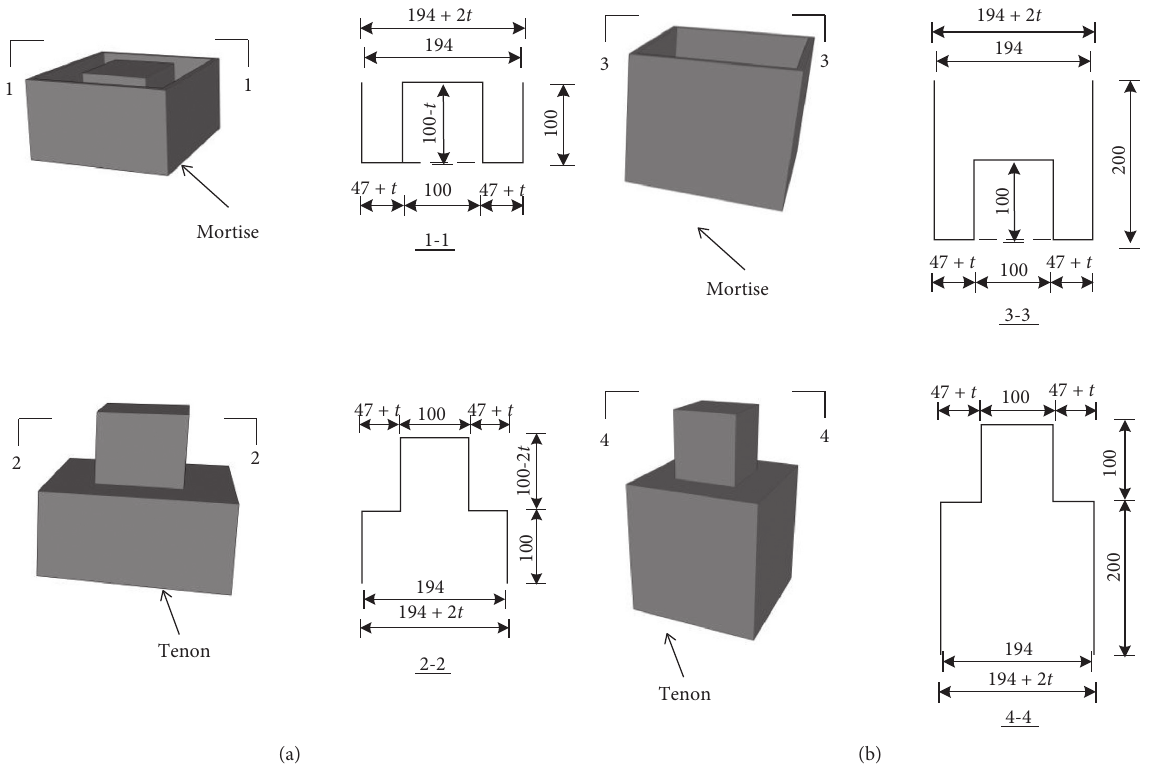
Figure 2: Details of the steel mortise and tenon connector (mm). (a) Connection mode A. (b) Connection mode